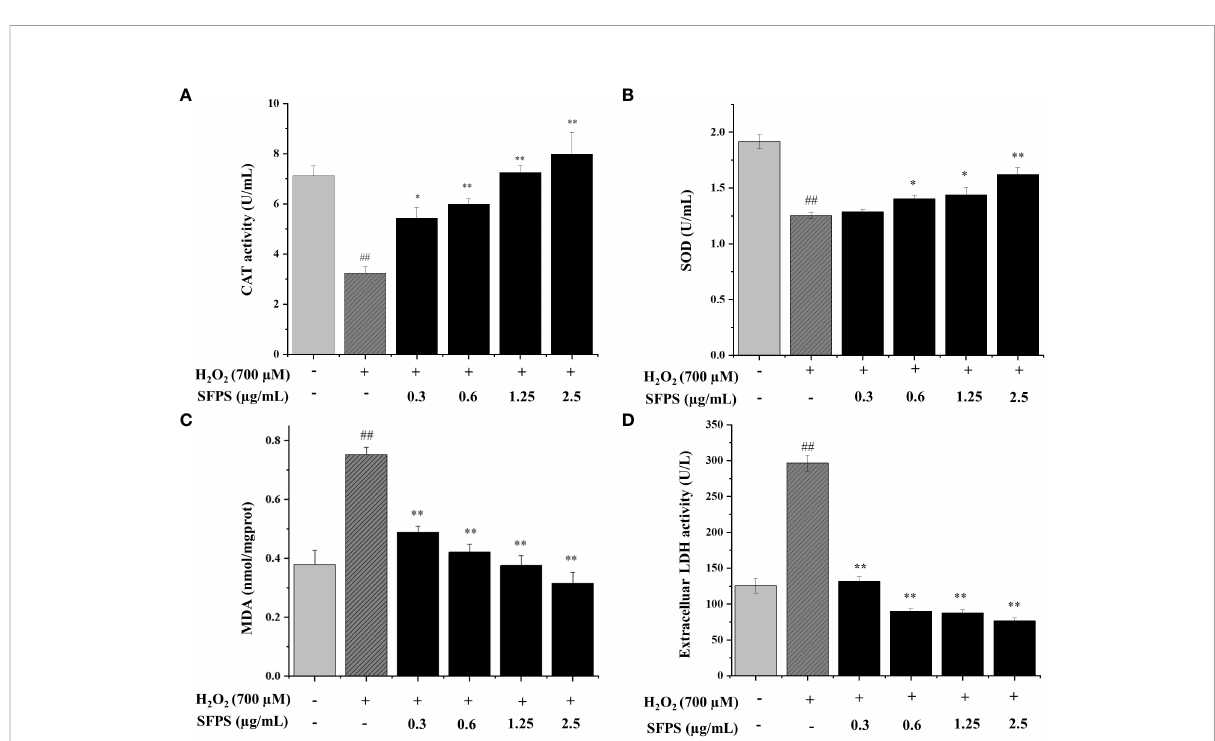
FIGURE 4 Effects of SFPS on CAT (A) , SOD (B) , MDA (C) and LDH leakage (D) in H 2 O 2 -treated LO2 cells. p < 0.01 (**) or p< 0.05 (*) means that columns between H 2 O 2 group and SFPS groups are signi fi cantly different. p< 0.01 (##) means that columns between the control group and the H 2 O 2 group are signi fi cantly different.